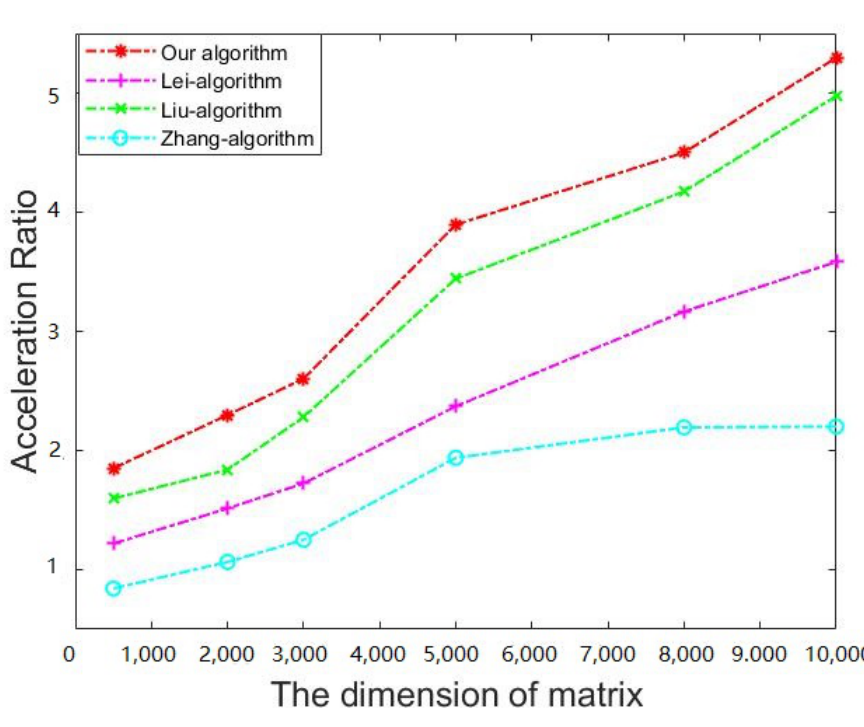
Figure 3. Acceleration ratio of the client.